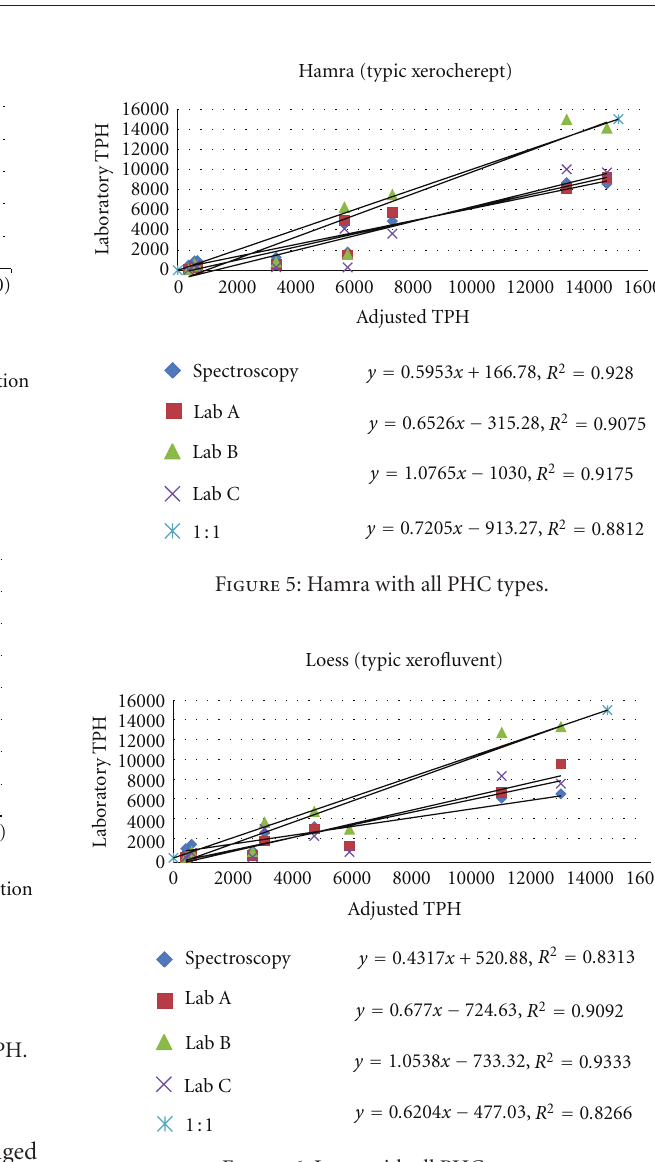
Figure 6: Loess with all PHC